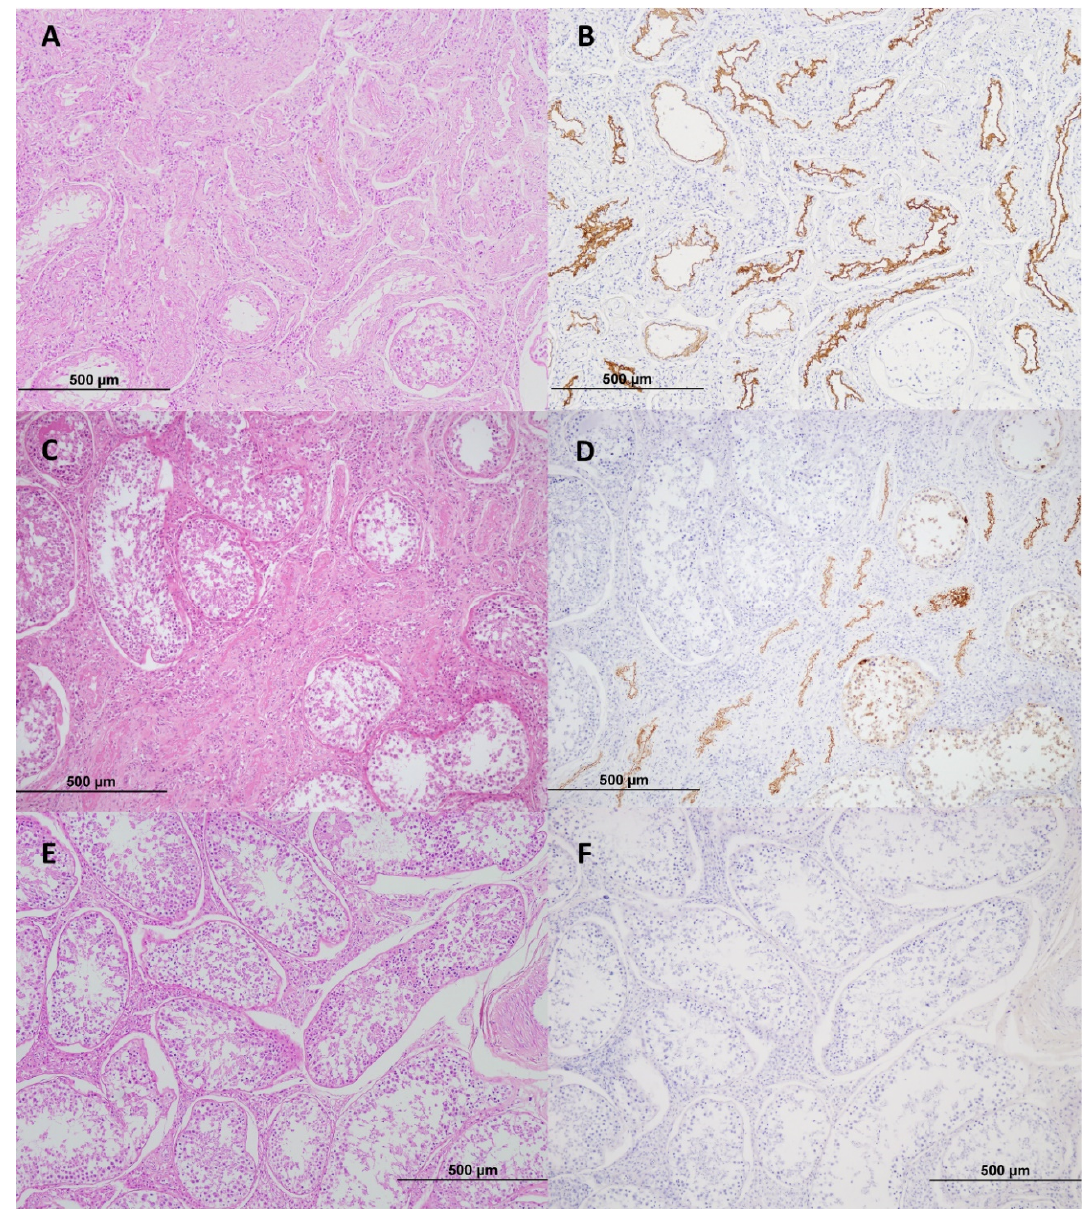
Figure 2. ( A ) Locally extensive areas of seminiferous tubular atrophy and fibrosis in a BVDV-infected bovine testicle. Many tubules are collapsed and shrunken with total loss of Sertoli cells, with a few tubules retaining some Sertoli cells but no germinal cells. The lower right quadrant contains a tubule with germinal cells. Haematoxylin and eosin (H&E) stain, 10×. ( B ) Non-serial section of A. Collapsed tubules have circumferential profiles of intense BVDV staining at the luminal surface. BVDV immunohistochemistry (IHC), 10×. ( C ) Collapsed seminiferous tubules intermingle with less-affected or relatively histologically normal tubules (lower right and upper left, respectively) in a BVDV-infected testicle. H&E stain, 10×. ( D ) Serial section of C; Collapsed tubules have intense BVDV staining while adjacent less-affected tubules (lower right) have BVDV staining within still-existing germinal cell stages and Sertoli cells. Histologically normal tubules (upper left) are BVDV antigen negative. BVDV IHC, 10×. ( E ) Histologically normal testicular tissue in the BVDV PCR negative contralateral testicle from Bull 2. H&E stain, 10×. ( F ) Serial section of E. The contralateral testicle is BVDV antigen negative. BVDV IHC, 10×.